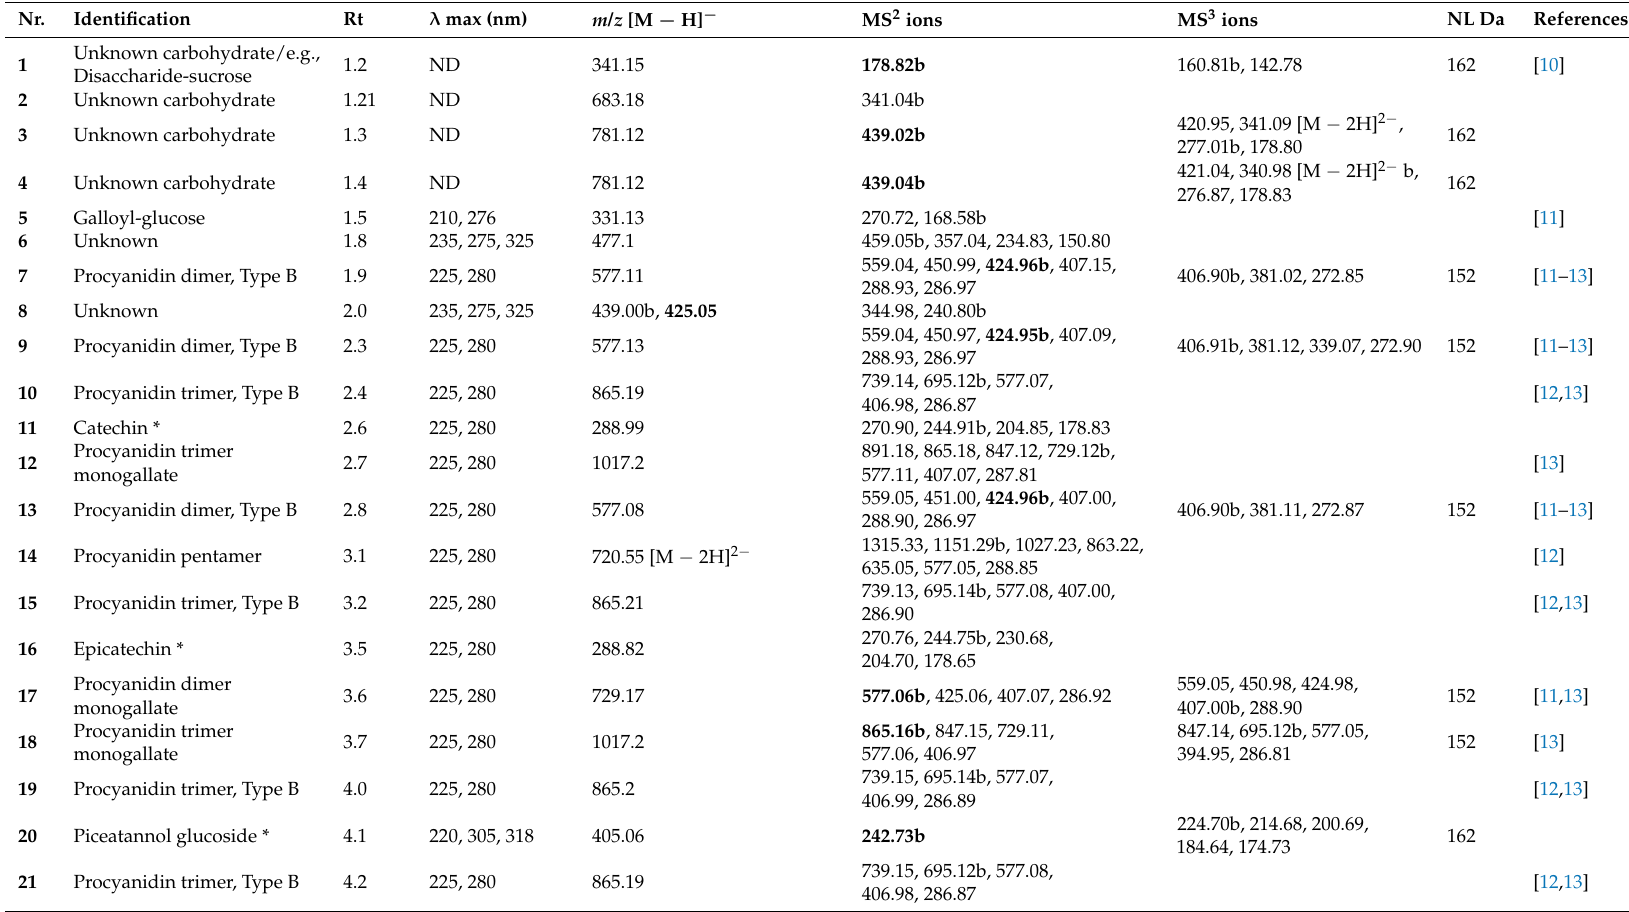
Table 1. Retention times, MS data, and UV λ max values of the constituents detected in the extracts and fractions of the three Reynoutria species.